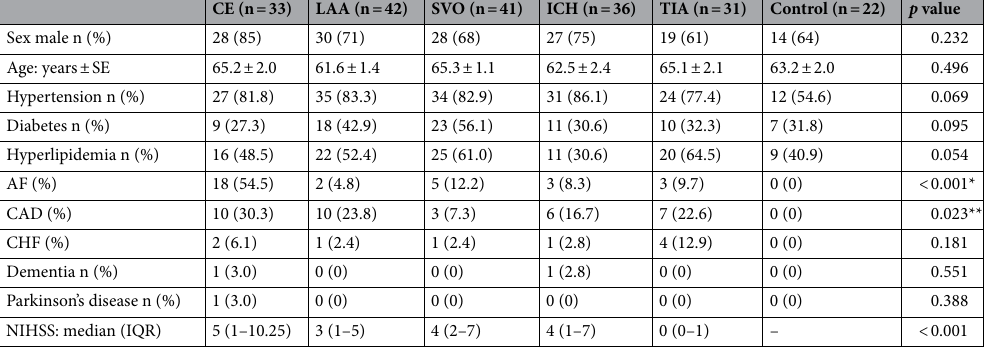
Table 1. Demographic variables in different type of stroke, TIA, and healthy controls. CE cardioembolic, LAA large artery atherosclerosis, SVO small-vessel occlusion, TIA transient ischemic attack, AF atrial fibrillation, CAD coronary artery disease, CHF congestive heart failure, SE standard error of the mean, NIHSS National Institutes of Health Stroke Scale, IQR Interquartile range. * p value for chi-square of total 6 groups. CE to control: p < 0.001; LAA to control: p = 0.542; SVO to control: p = 0.153; ICH to control: p = 0.281; TIA to control: p = 0.258. ** p value for chi square of total 6 groups. CE to control: p = 0.004; LAA to control: p = 0.012; SVO to control: p = 0.546; ICH to control: p = 0.073; TIA to control: p =